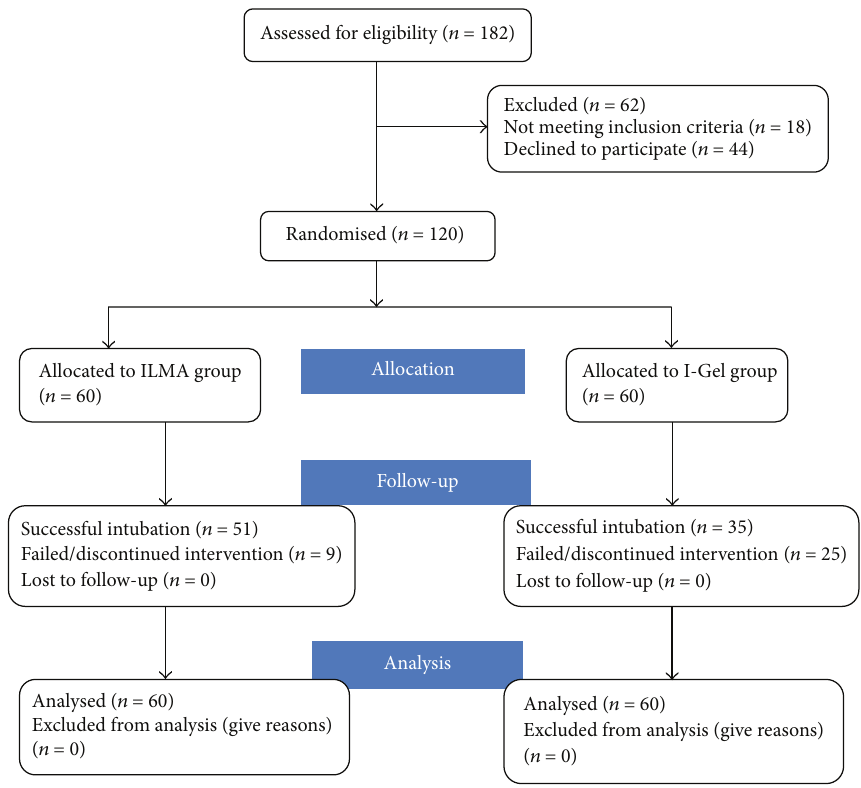
Figure 1: CONSORT